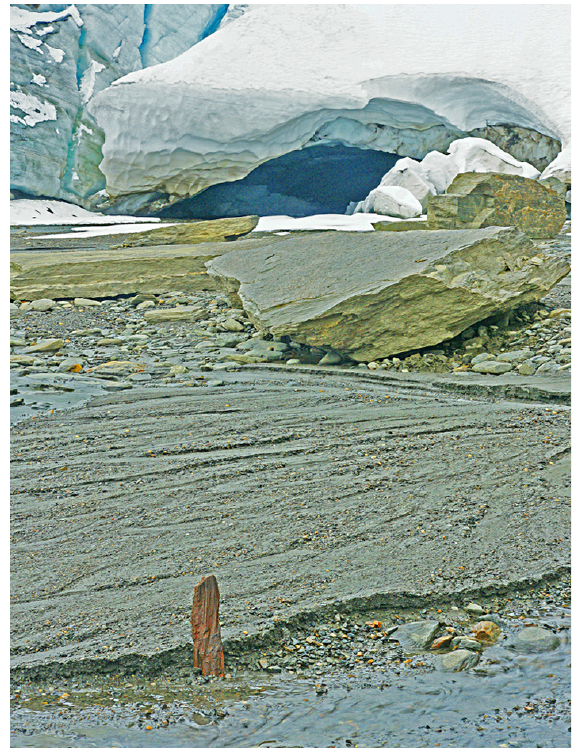
Figure 37: Kårsajökeln (8). Lower part of a small pine tree, with some roots preserved. Recently outwashed from beneath the glacier. 6790 cal. yr BP (Beta-264384).